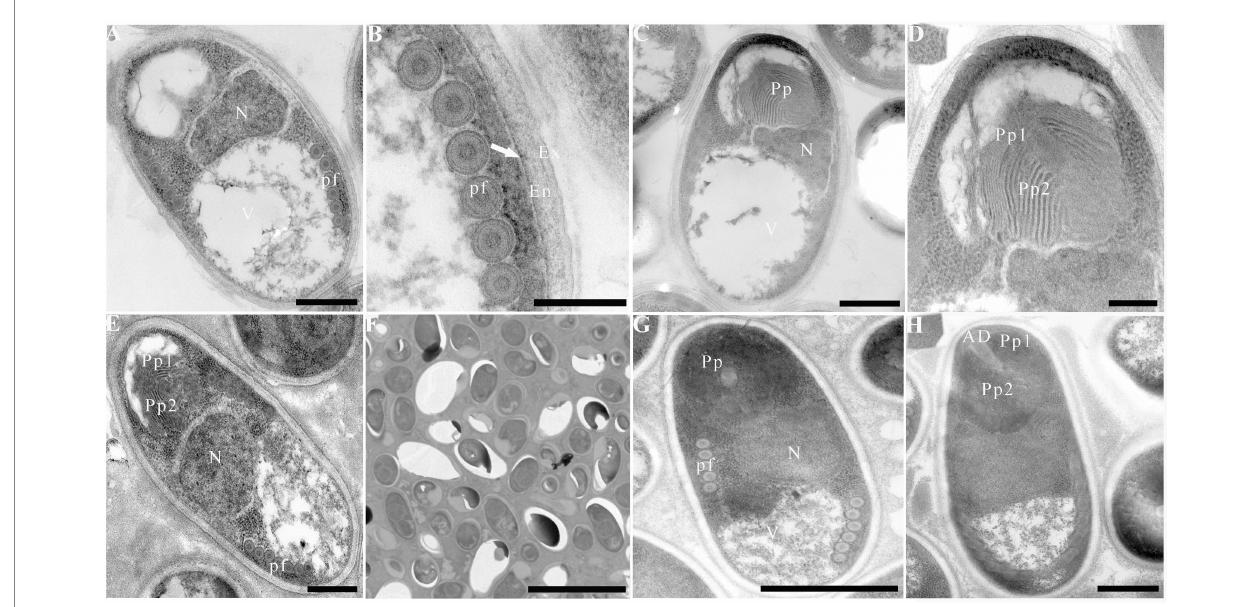
FIGURE 5 Electron microscopy of Pseudokabatana alburnus isolated from different fish. (A) A mature spore of P. alburnus isolated from Cultrichthys erythropterus showing six coils of polar filament (pf), a vacuole (V) and a large nucleus (N). Scale bar = 500 nm. (B) Magnification of trilaminar spores wall showing an electron-dense exospore (Ex), an electron-translucent endospore (En) and a plasma membrane (arrow). Scale bar = 200 nm. (C) A mature spore of P. alburnus isolated from C. erythropterus with bipartite polaroplast, a vacuole and a large nucleus. Scale bar = 500 nm. (D) Magnification of bipartite polaroplast (Pp1, Pp2). Scale bar = 200 nm. (E) A mature spore of P. alburnus isolated from Pseudolaubuca engraulis with a bipartite polaroplast (Pp1, Pp2), a large nucleus (N) and the isofilar polar filaments (pf). Scale bar = 500 nm. (F) Mature spores occur in direct contact with the host cell cytoplasm. Scale bar = 5 μ m. (G) A mature spore of P. alburnus isolated from Elopichthys bambusa showing 5–6 coils of polar filament (pf), a vacuole (V) and a large nucleus (N). Scale bar = 500 nm. (H) A mature spore of P. alburnus isolated from E. bambusa showing bipartite polaroplast (Pp1, Pp2) and a mushroom-shaped anchoring disk (AD). Scale bar = 500